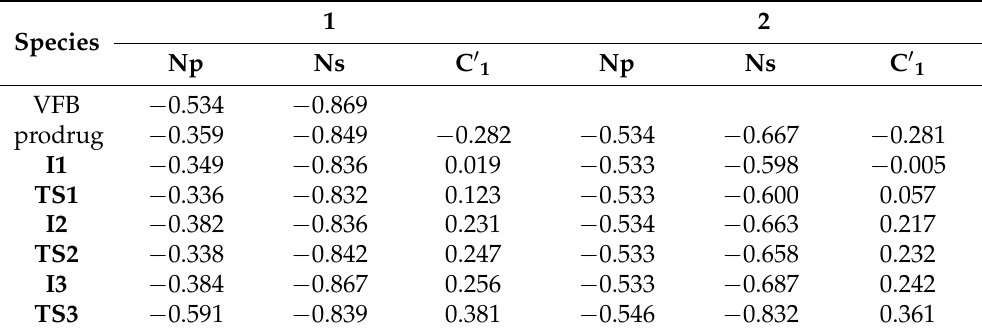
Table 2. The NBO charges (a) of key atoms (b) of the intermediates and TSs of photouncaging reactions of prodrugs 1 and 2